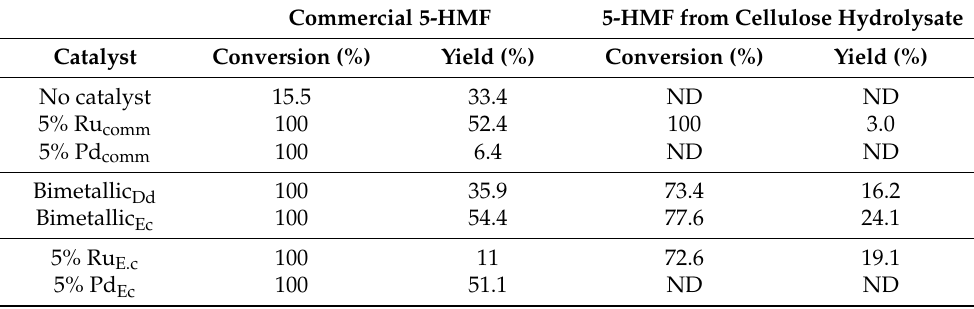
Table 2. One-pot catalytic upgrading of 5-HMF to 2,5-DMF in cellulose hydrolysate. Commercial catalyst ( comm ); Desulfovibrio desulfuricans ( Dd ) 5% Pd/5% Ru; Escherichia coli ( Ec ) 5% Pd/5% Ru. ND: not determined. Errors between technical replicates and between experiments were within 10%. Bold: comparison between the two Gram-negative strains. This table contains average values of two experiments. Actual composition of bimetallic Ec was (5%Pd/4.7%Ru), 5%Ru Ec (2.6%Ru)